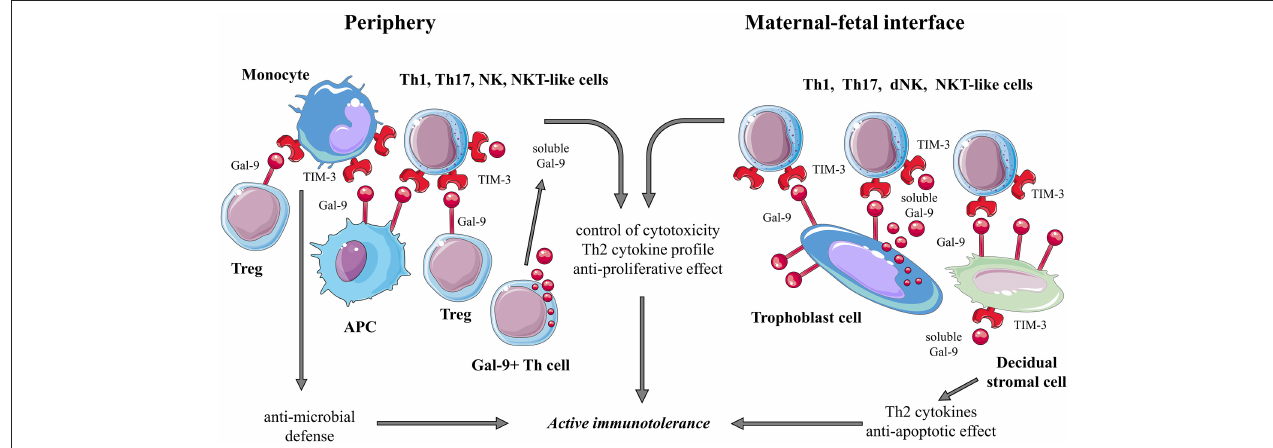
FIGURE 2 | Summarizing the possible role of the TIM-3/Gal-9 pathway during human pregnancy.